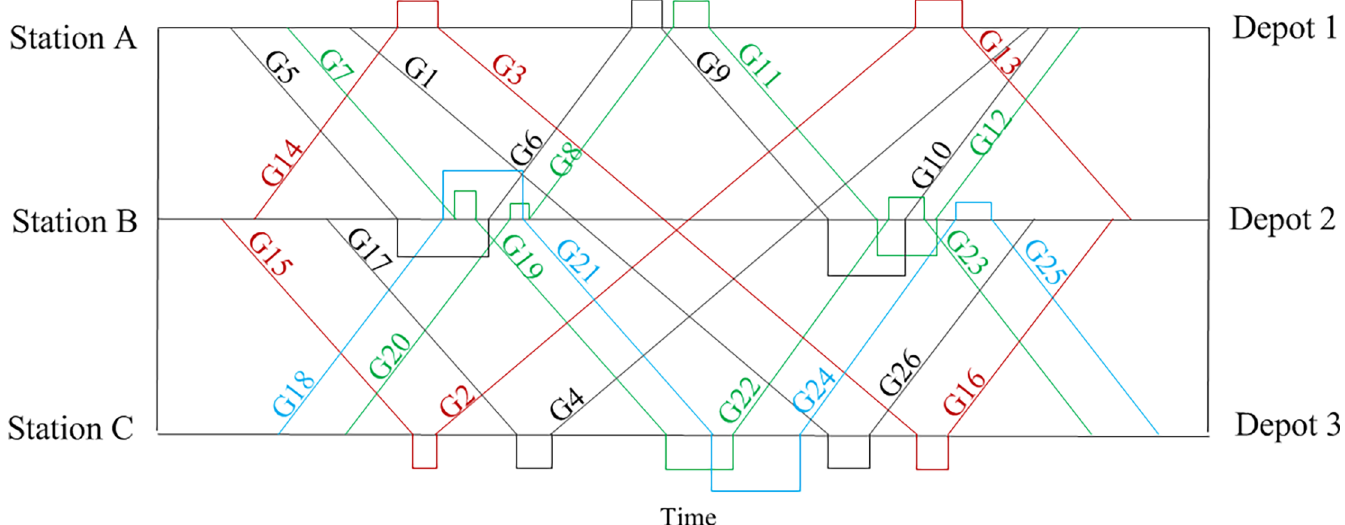
Fig 7. EMU circulation plans in the collaborative mode subject to the maintenance capacity limitation based on the time-space diagram.